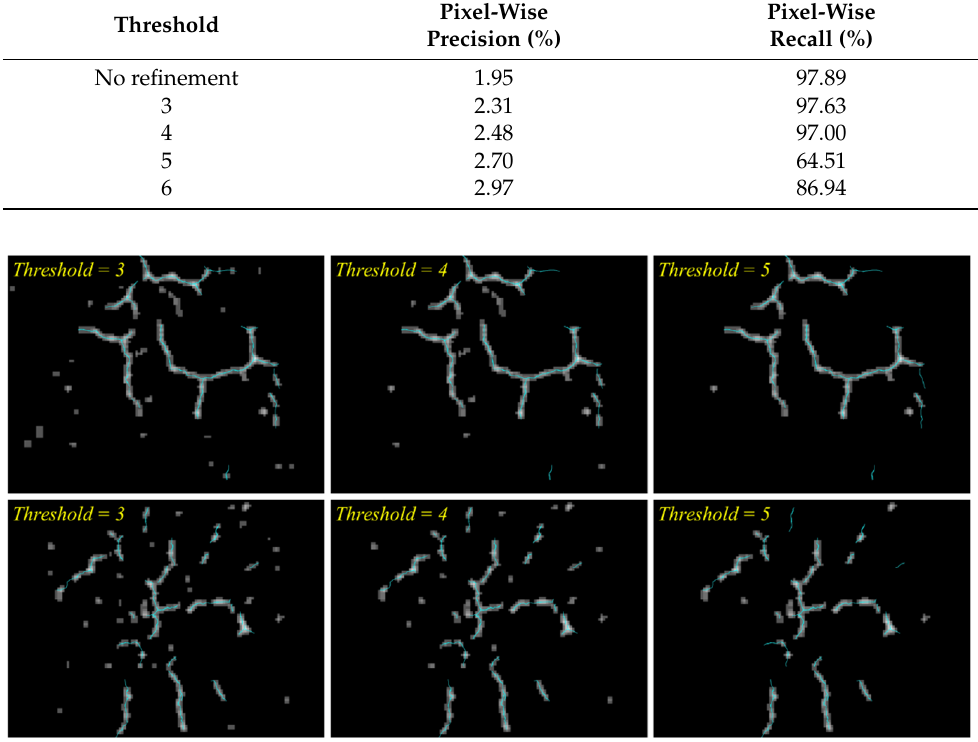
Figure 11. Examples of the blob images visualized with the ground truth crack lines.